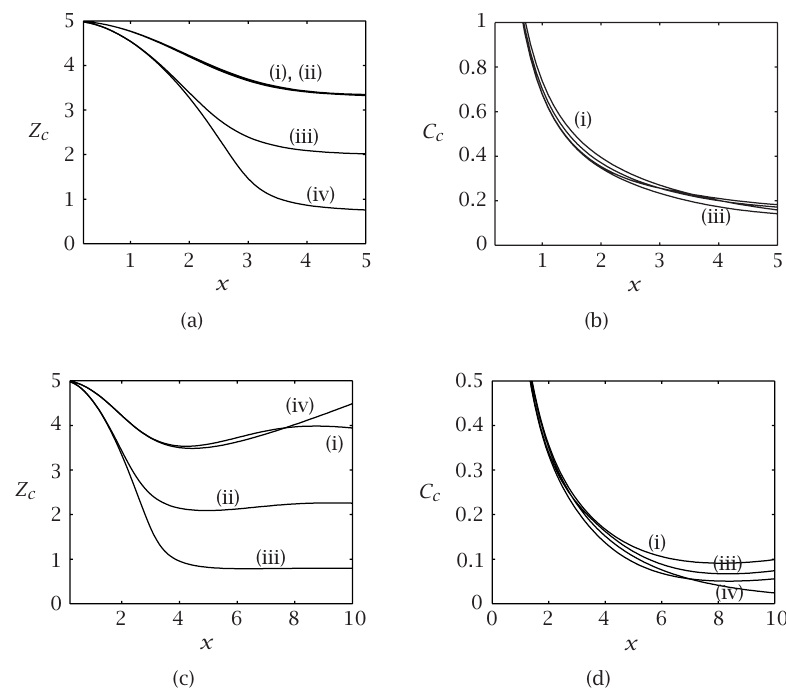
Figure 6.3 . An illustration of the dependence of the curve of ex- tensive pollution, height Z c , and concentration C c along it on the parameters of the point source problem. (a) and (b) correspond to t = 5 . 0, h = 5 . 0, and (i) z o = 0 . 5, ν = 0 . 5, b = 2 . 0; (ii) z o = 0 . 5, ν = 0 . 5, b = 3 . 0; (iii) z o = 0 . 5, ν = 1 . 5, b = 2 . 0; and (iv) z o = 0 . 1, ν = 0 . 5, b = 2 . 0, respectively. (c) and (d) again correspond to h = 5 . 0, and (i) z o = 0 . 5, ν = 0 . 5, b = 3 . 0, t = 10 . 0; (ii) z o = 0 . 5, ν = 1 . 5, b = 3 . 0, t = 10 . 0; (iii) z o = 0 . 1, ν = 1 . 5, b = 3 . 0, t = 10 . 0; and (iv) z o = 0 . 5, ν = 0 . 5, b = 3 . 0, t = 50 . 0,